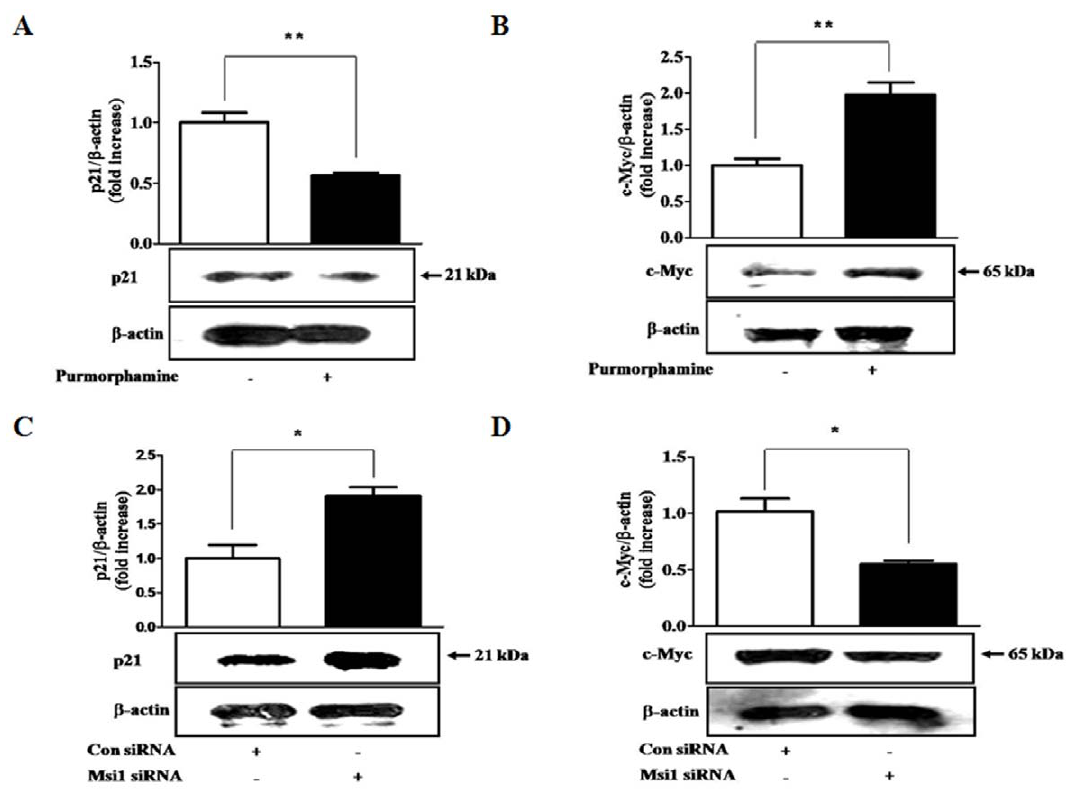
Figure 5. The effects of purmorphamine and Msi1 knockdown on p21 CIP1,WAF1 and c-Myc expression. hUCB-MSCs and hDFs were incubated in standard culture medium with or without 4 m M purmorphamine for 3 days. p21 CIP1,WAF1 and c-Myc expressions levels were then assessed by western blotting. Purmorphamine treatment decreased and increased the expression of p21 CIP1,WAF1 ( A ) and c-Myc ( B ), respectively. After preculture for 24 h, hUCB-MSCs were transfected with 50 nM Msi1 siRNA for 48 h. The transfection of 50 nM Msi1 siRNA significantly increased and decreased the expression levels of p21 CIP1,WAF1 ( C ) and c-Myc ( D ), respectively. b -actin was used as an internal control. The results are shown as the mean 6 SD from three independent experiments. * P , 0.05, ** P , 0.01, and *** P , 0.001.